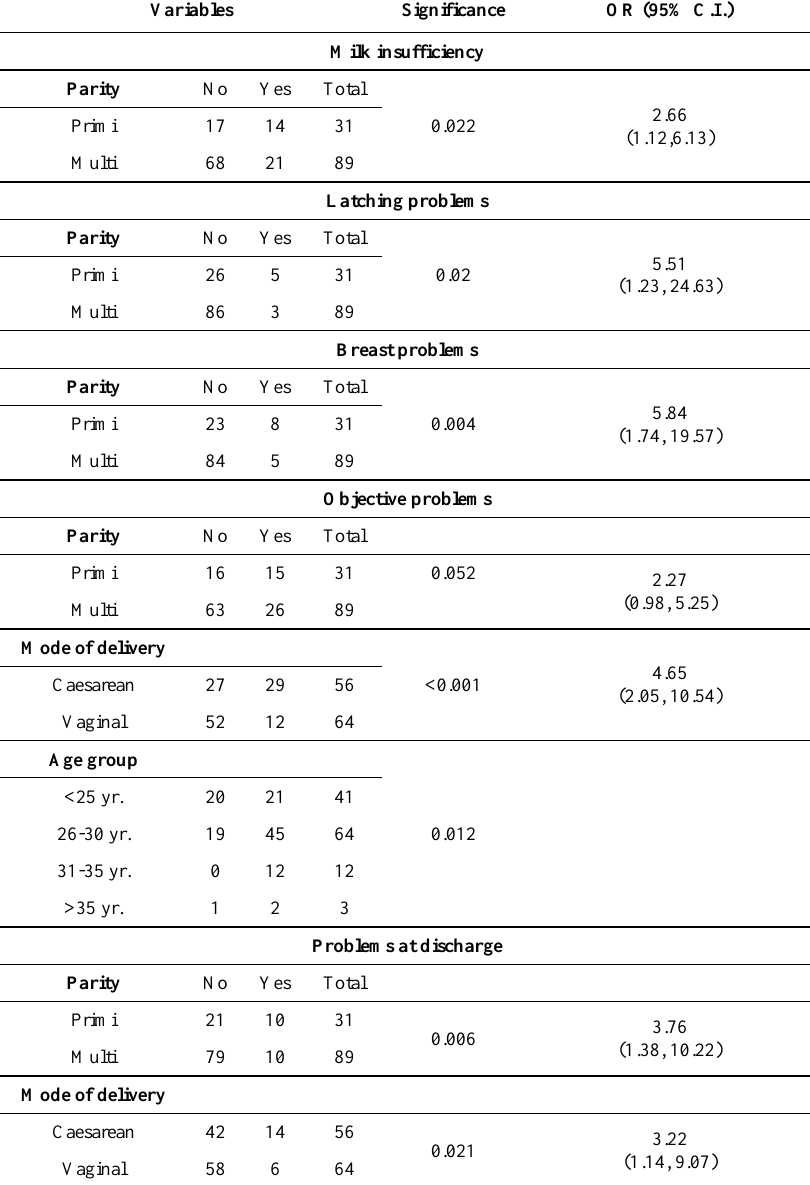
Table 5. Correlation of breast feeding issues with selected variables